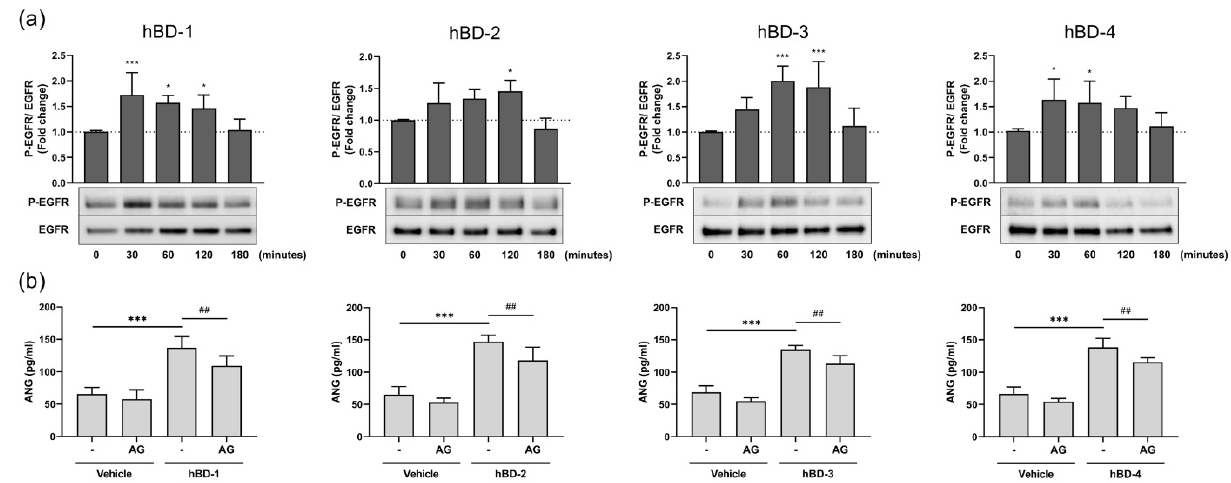
Figure 3. hBDs induce ANG production by activating the EGFR pathway. ( a ) Human dermal fibroblasts were stimulated with 20 µ g/mL hBD-1, 20 µ g/mL hBD-2, 10 µ g/mL hBD-3, or 20 µ g/mL hBD-4 for 30–120 min, and the levels of phosphorylated and unphosphorylated EGFR in whole cell lysates were analyzed by Western blotting. * p < 0.05 and *** p < 0.001 compared between the unstimulated (0 min) and the hBD-stimulated groups by one-way ANOVA with Tukey’s multiple comparisons test. ( b ) Fibroblasts were preincubated with 100 nM AG1478 (AG, EGFR inhibitor) or solvent (-) for 2 h. Cells were then stimulated for 6 h with 20 µ g/mL hBD-1, 20 µ g/mL hBD-2, 10 µ g/mL hBD-3, or 20 µ g/mL hBD-4. The concentrations of ANG in cell-free supernatants were determined by ELISA. *** p < 0.001 compared between the presence and absence of hBDs without inhibitors; ## p < 0.01 compared between the inhibitor-treated and untreated group with hBD stimulation by one-way ANOVA with Tukey’s multiple comparisons test. All results are the means ± SDs of 5–6 independent experiments.